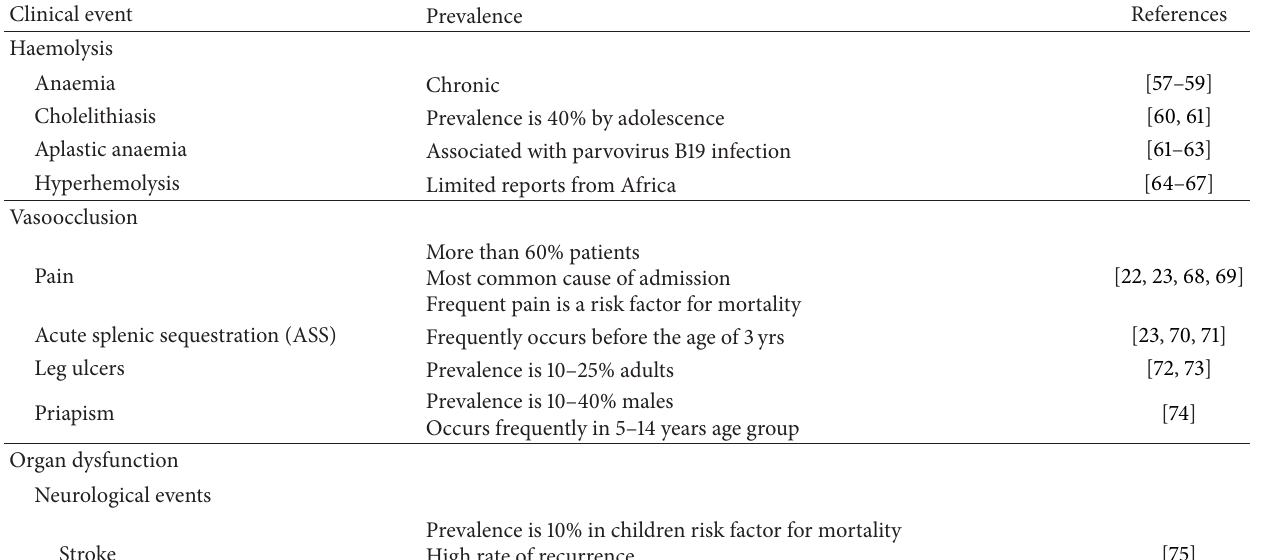
Table 2: The prevalence of selected clinical consequences of